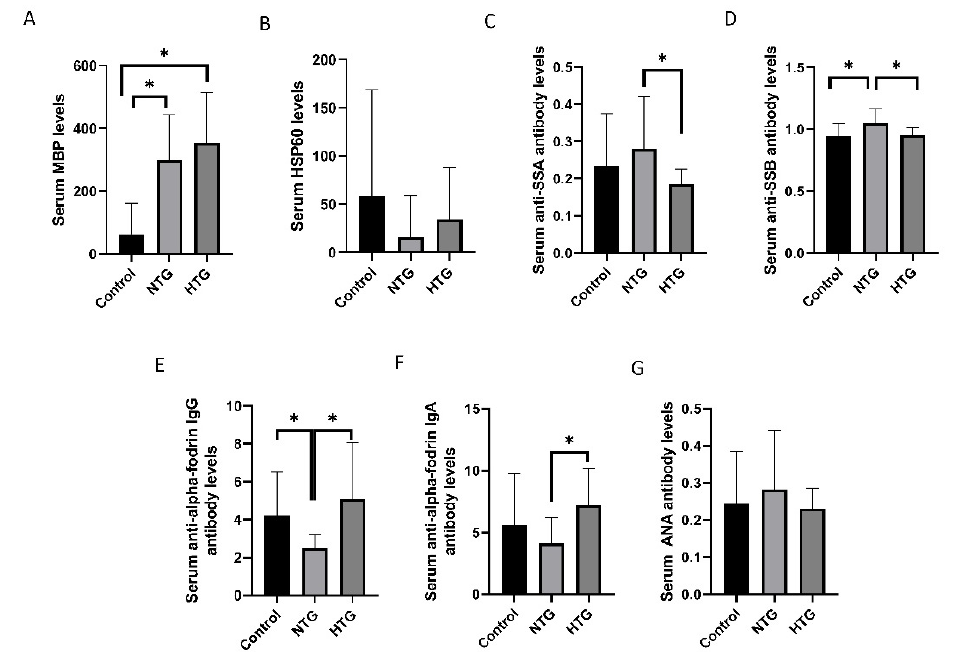
Figure 4. Comparison of serum markers between normal-tension glaucoma (NTG) and high-tension glaucoma (HTG). ( A , B ) Serum myelin basic protein (MBP) levels were higher in NTG and HTG compared to the control group, and heat Scheme 60. (HSP60) levels were not different between the NTG and HTG groups. ( C ) Serum anti-Sjögren’s-syndrome-related antigen A (SSA) antibody level in the NTG group was higher than that in the HTG group. ( D ) Serum anti-Sjögren’s-syndrome-related antigen B (SSB) antibody level in the NTG group was higher than those in the HTG group or controls. ( E ) The NTG group showed a lower serum anti- α -fodrin IgG level than the HTG and control groups. ( F ) Serum anti- α -fodrin IgA level in the HTG group was higher than that in the NTG group. ( G ) There was no difference in serum anti-nucleic acid (ANA) antibody levels between the groups. * p < 0.05 by Mann–Whitney U test.